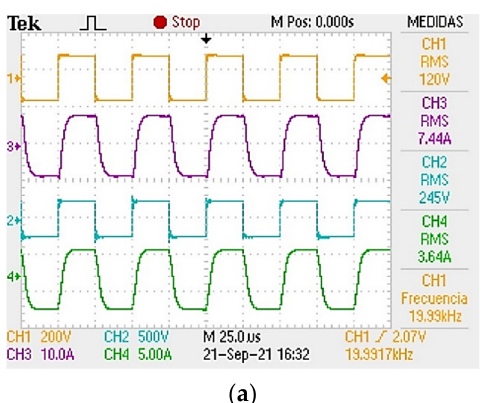
The high efficiency of the nanocrystalline MFT is 99.8%, and 97.9% of the ferrite MFT. Table 10. Input and output voltages and currents, and efficiency obtained at full load.